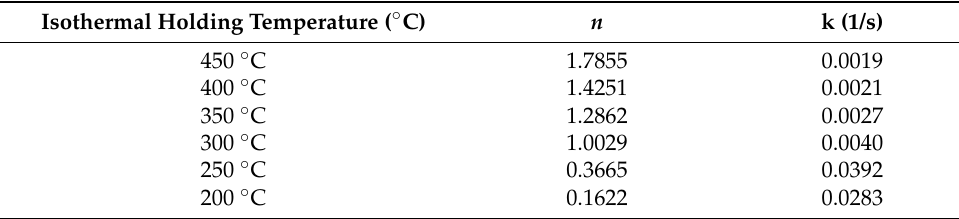
Table 2. Parameters n and k derived from linear regression equations describing the dilatation behaviours at various isothermal holding temperatures in the range 450–200 ◦